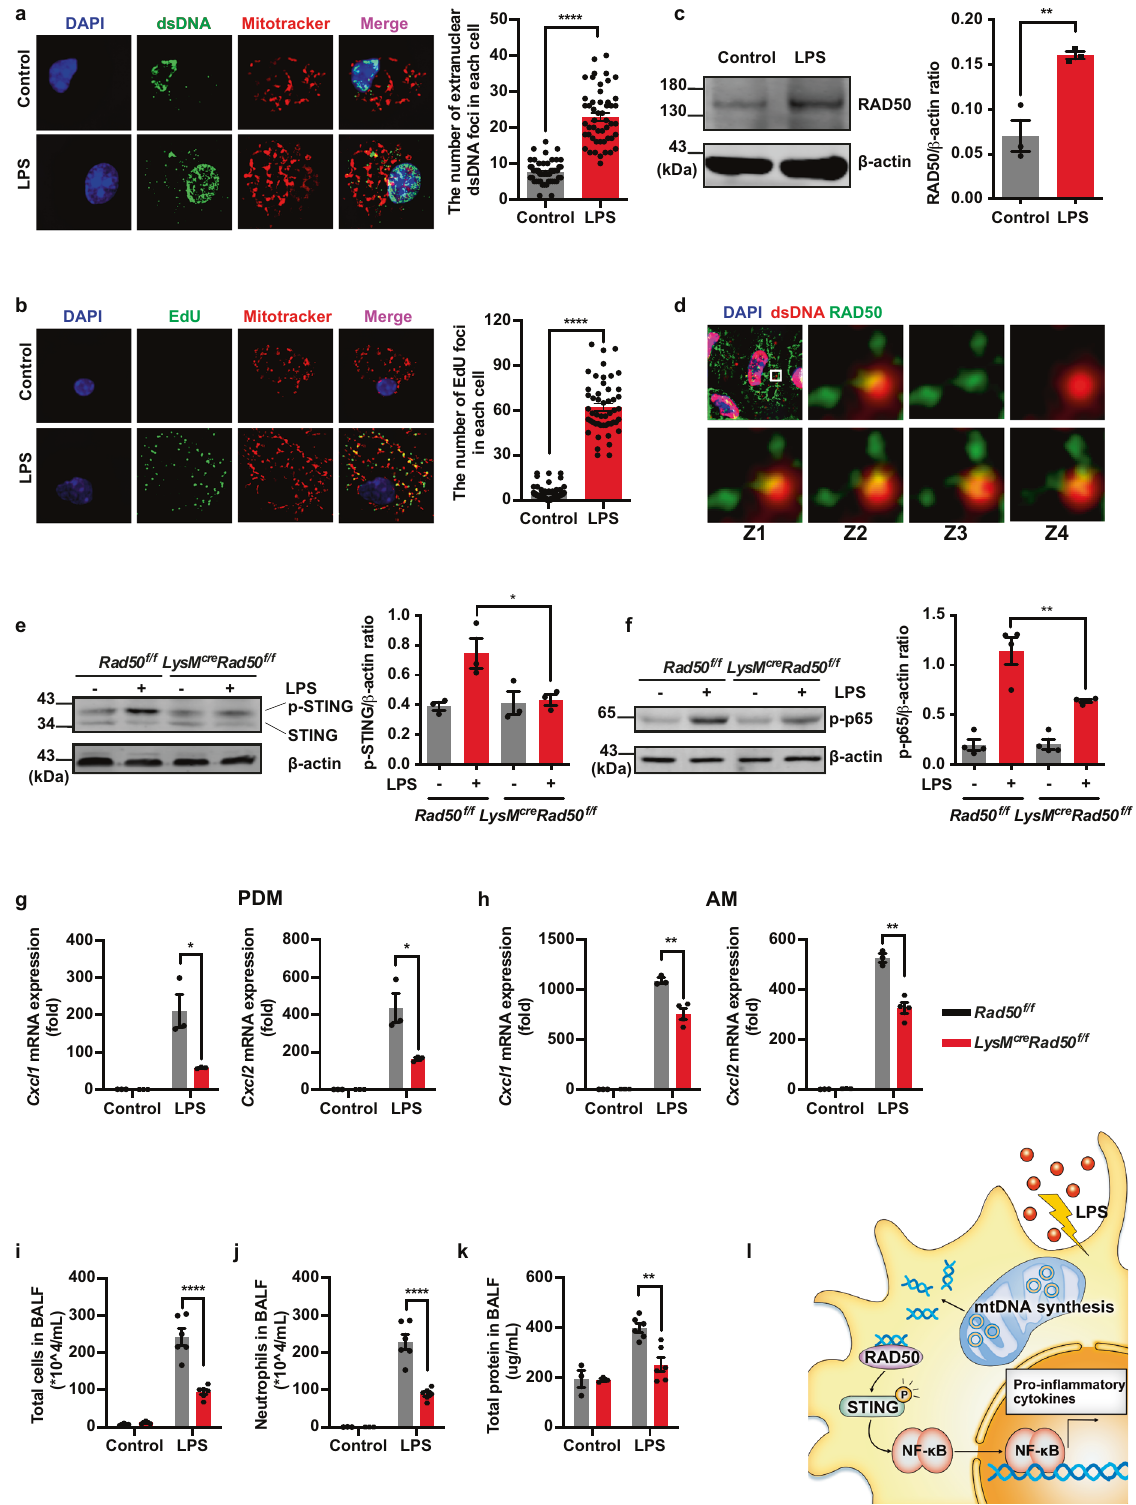
innate immunity. We found that LPS induced mtDNA synthesis and release, and caused increased cytosolic dsDNA, which was recognized by RAD50 in macrophages. This important process consequently contributed to the activation of STING and NF- κ B signaling pathway, and promoted pro-in fl